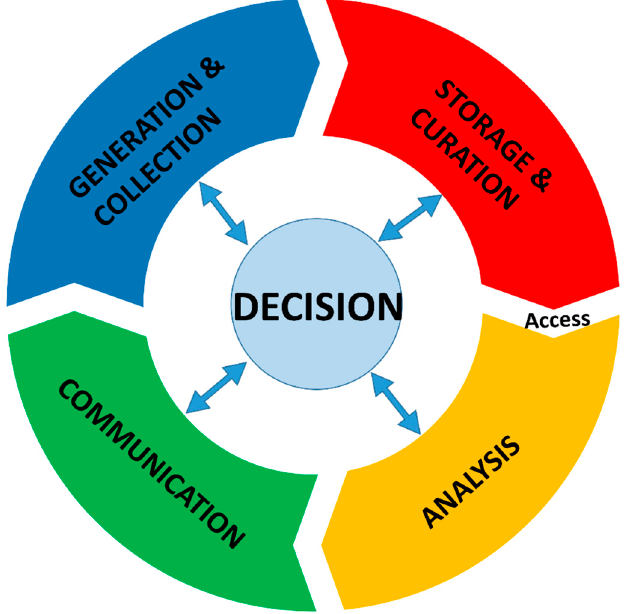
Figure 1. Schematic framework of data life cycle for engaging biodiversity science.